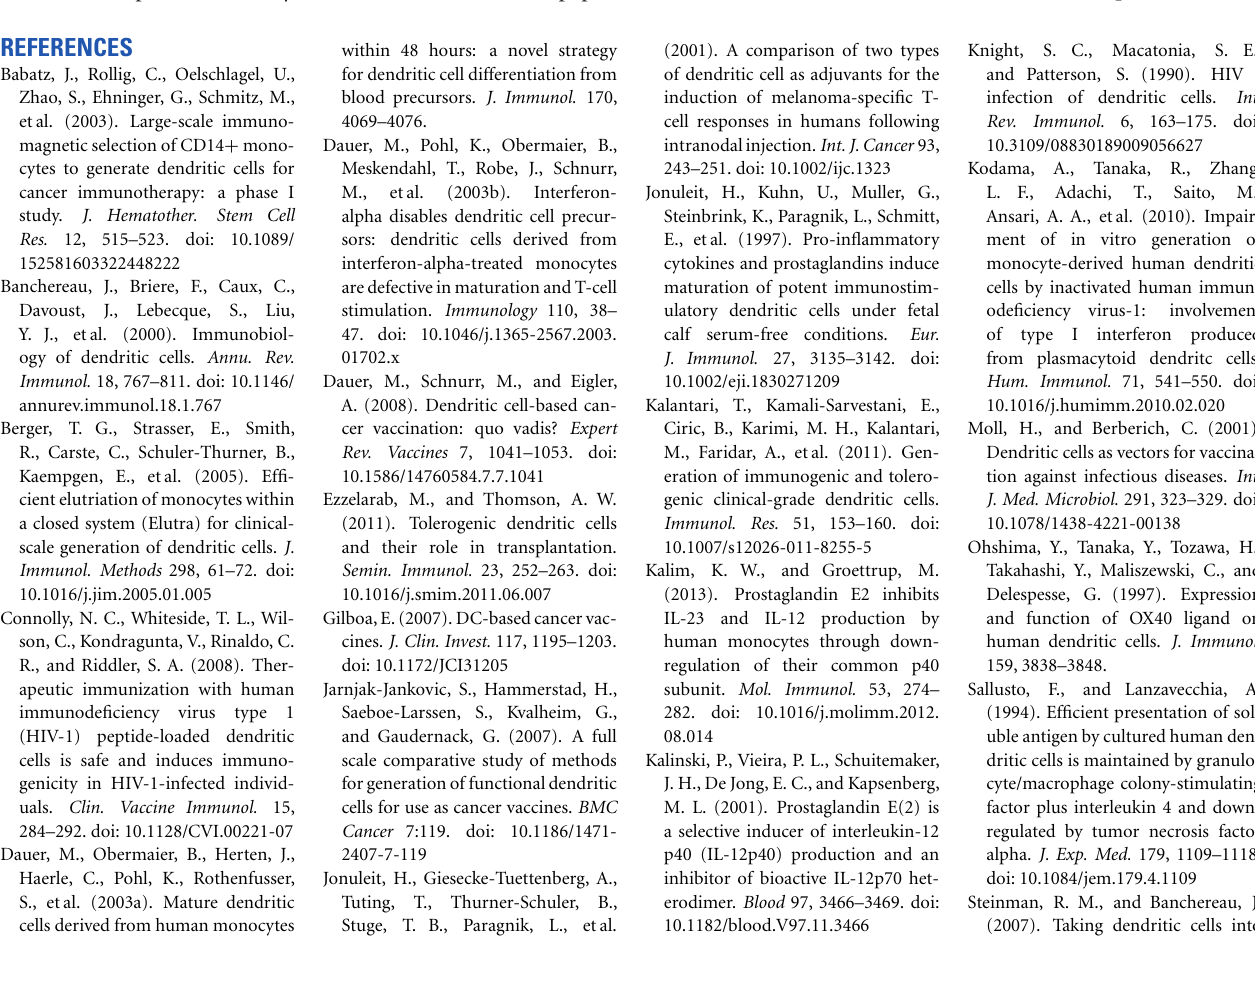
mice were sacrificed and human CD4 + T cells were purified from splenocytes.These CD4 + T cells were co-cultured with autologous APCs (adherent PBMCs) in the presence or absence of antigens (restimulation) for 2 days at 37 ◦ C. IFN- γ levels produced in the culture supernatants were measured by ELISA. Data show mean ± SD of triplicate cultures. * P < 0.05, ** P < 0.01, *** P < 0.001. Data shown are representative of three independent experiments using blood from two different